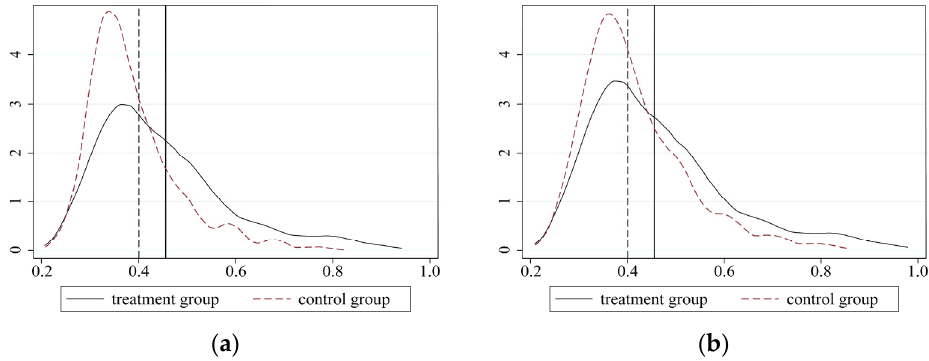
Figure 5. The P-score kernel density. ( a ) P-score before matching. ( b ) P-score after matching.